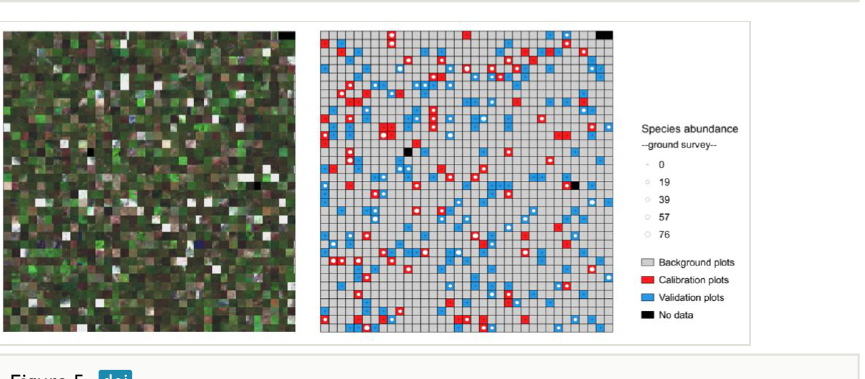
Figure 5. Some examples of reconstructed images: A. Sylt island reconstructed image and plot locations (wavelengths: 170R, 65G, 17B). B. Compiègne Forest reconstructed image and plot locations (wavelengths: 207R, 65G,